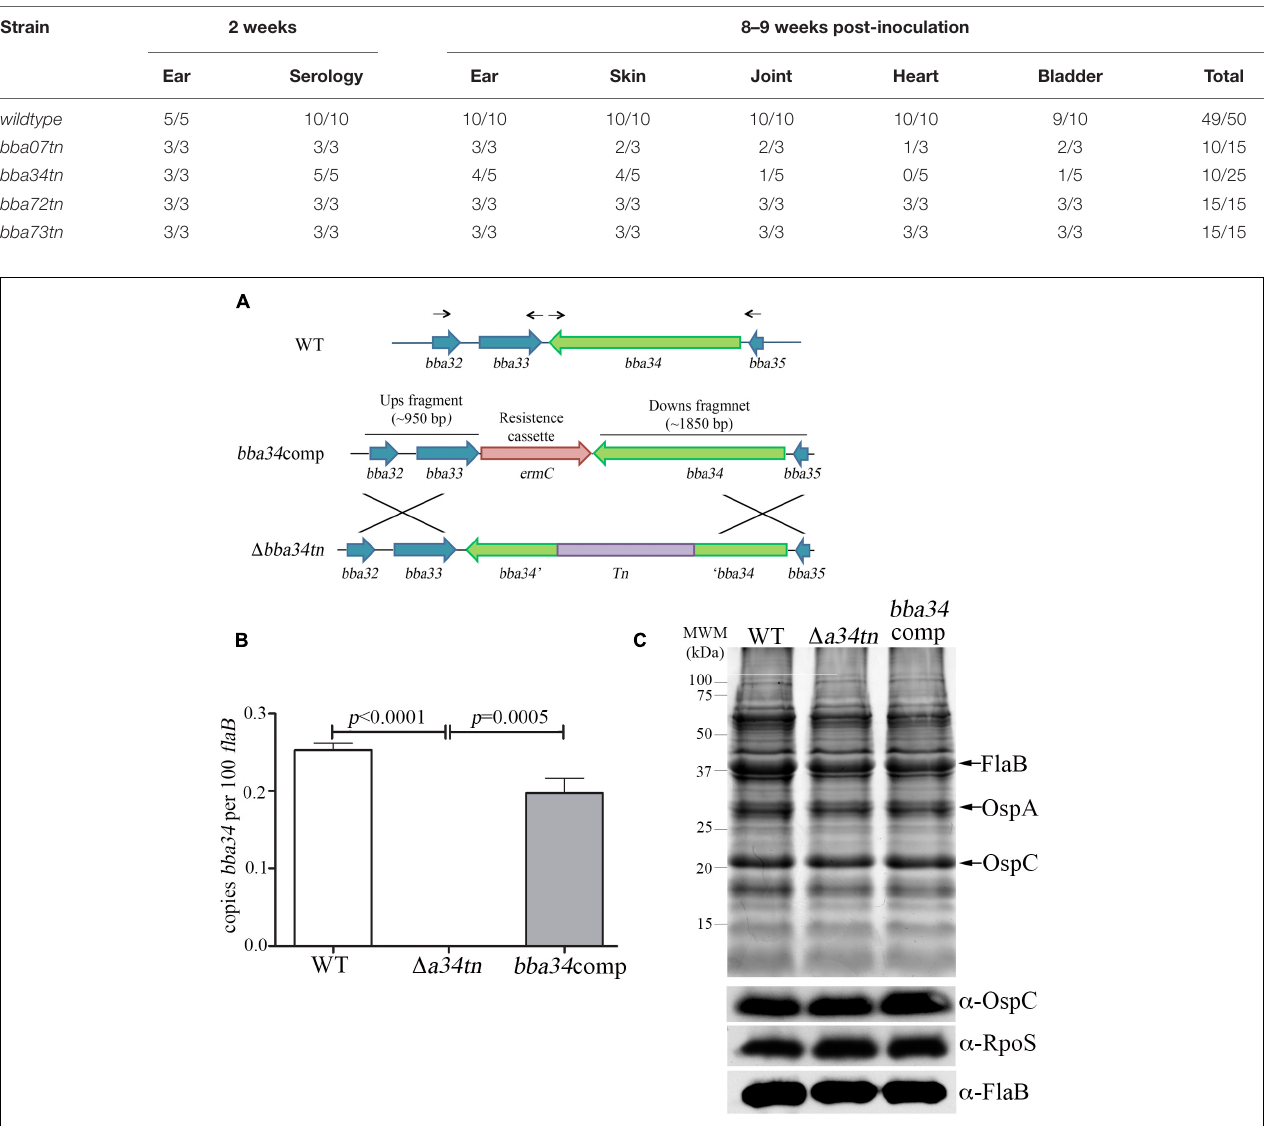
FIGURE 7 | Characterization of bba34 transposon mutant and complemented strains in vitro. (A) Cartoon schematic of wild-type (WT), bba34 transposon mutant ( (cid:49) a34tn ) and allelic-exchange strategy used to generate bba34 complement ( bba34comp ). Arrows shown above the WT loci indicate location of primers used to amplify upstream and downstream fragments in bba34 comp allelic replacement construct. qRT-PCR (B) and immunoblot (C) analyses of WT, (cid:49) a34tn and a34comp strains following temperature-shift in vitro . Transcript levels for bba34 were normalized using a TaqMan-assay for flaB . Error bars indicate standard errors of the